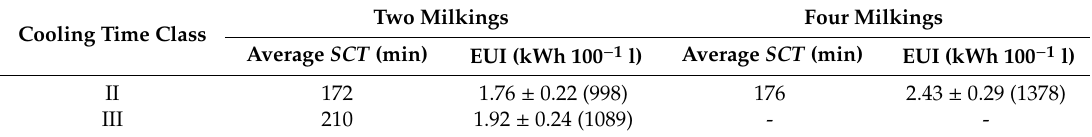
Table 4. Average EUI S of the sample. The CO 2 emissions (g CO 2 100 L − 1 ) are reported in